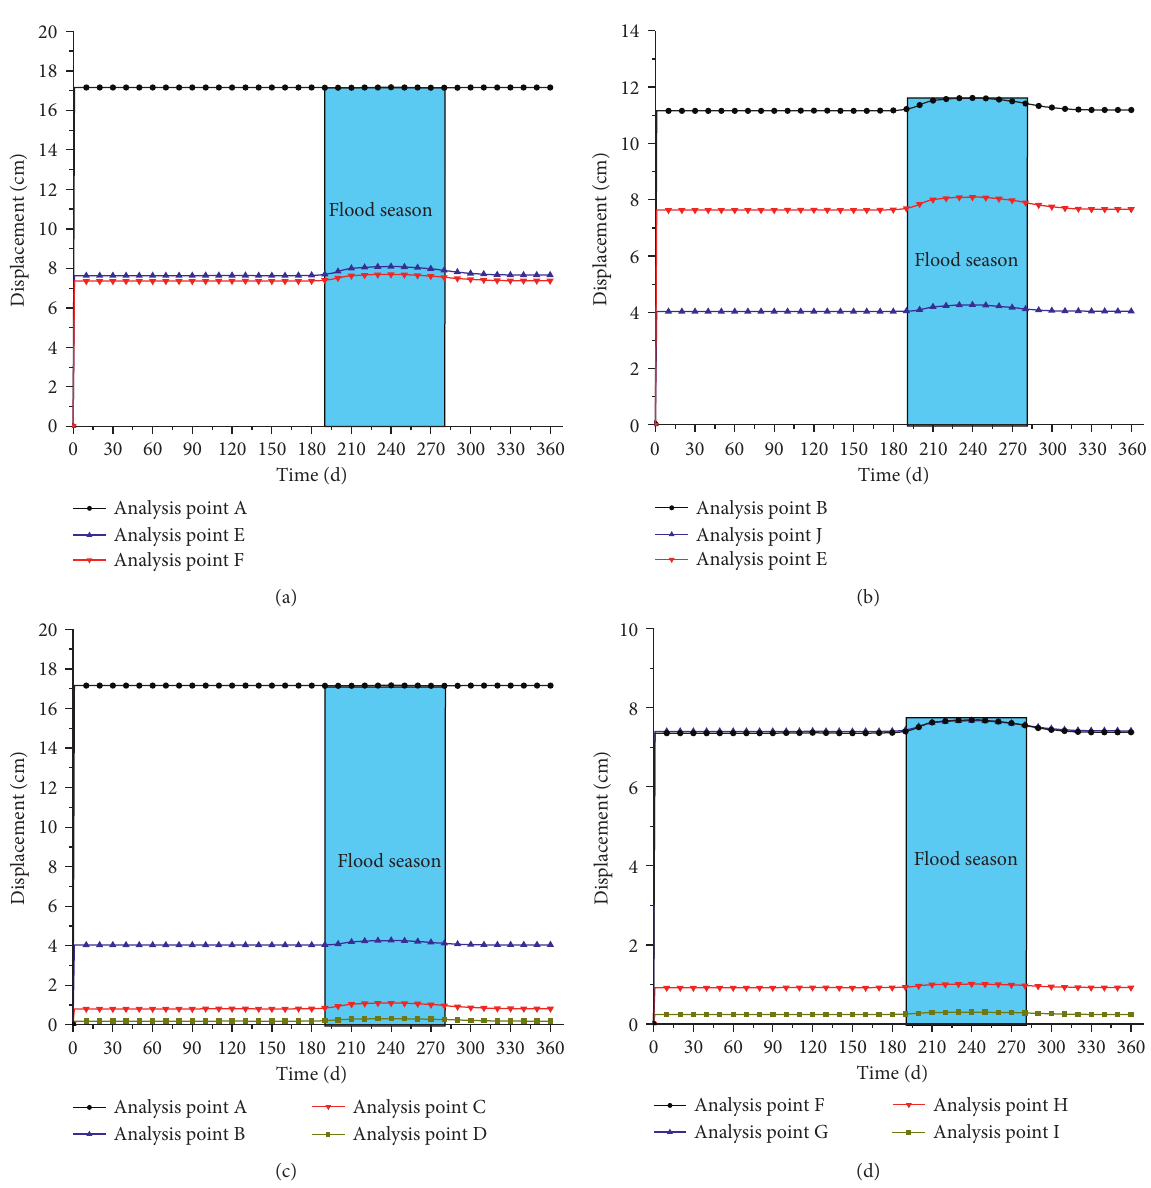
Figure 9: Schematic diagram of selection of cofferdam deformation analysis points underwater-level fluctuation: (a) deformation of the backwater slope of the cofferdam; (b) deformation of the interface between outsourcing oil and the filler; (c) vertical section deformation at the top of the cofferdam; (d) vertical section deformation at the horse track.